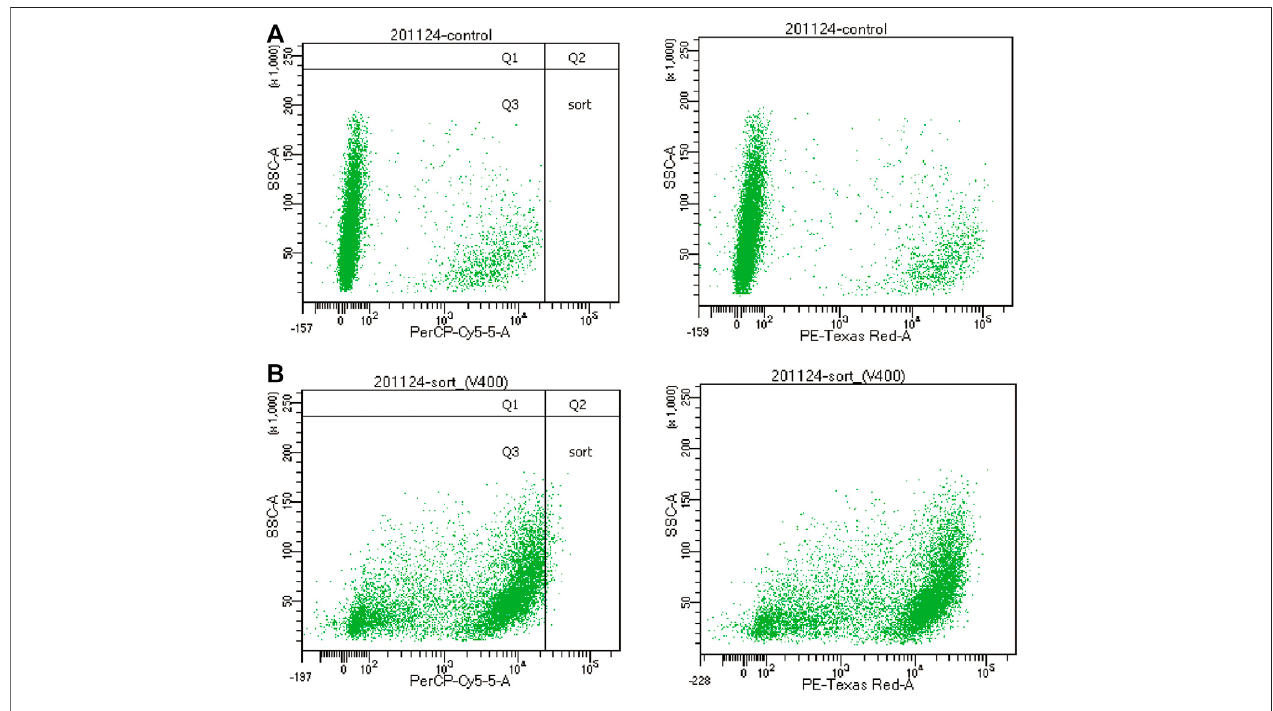
FIGURE6| Cellpopulationsunderdifferent fl uorescenceintensitiesofthe fl owcytometer. (A) :CellgroupingunderNileRedstainingofnon-squalene-producing S. cerevisiae . (B) : Cell grouping under Nile Red staining of squalene-producing S. cerevisiae . “ Sort ” represents the distribution of cells that we need to screen out.